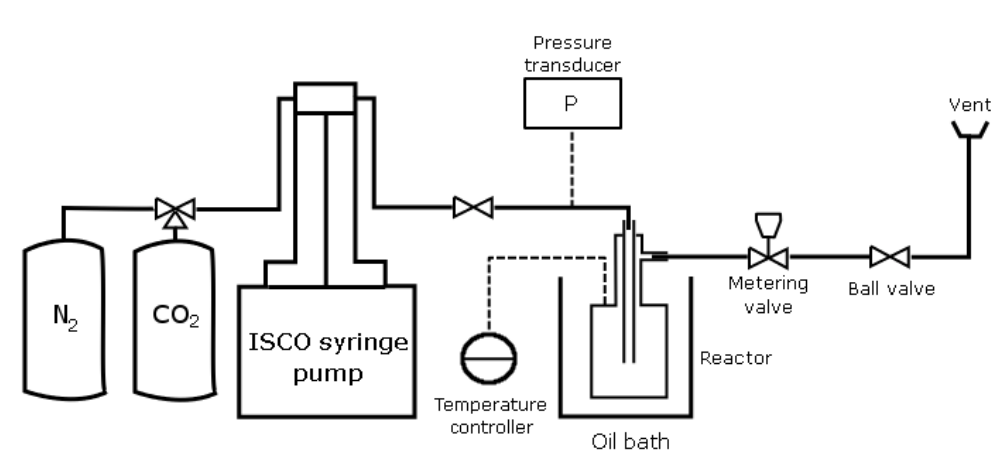
Figure 2. High pressure vessel